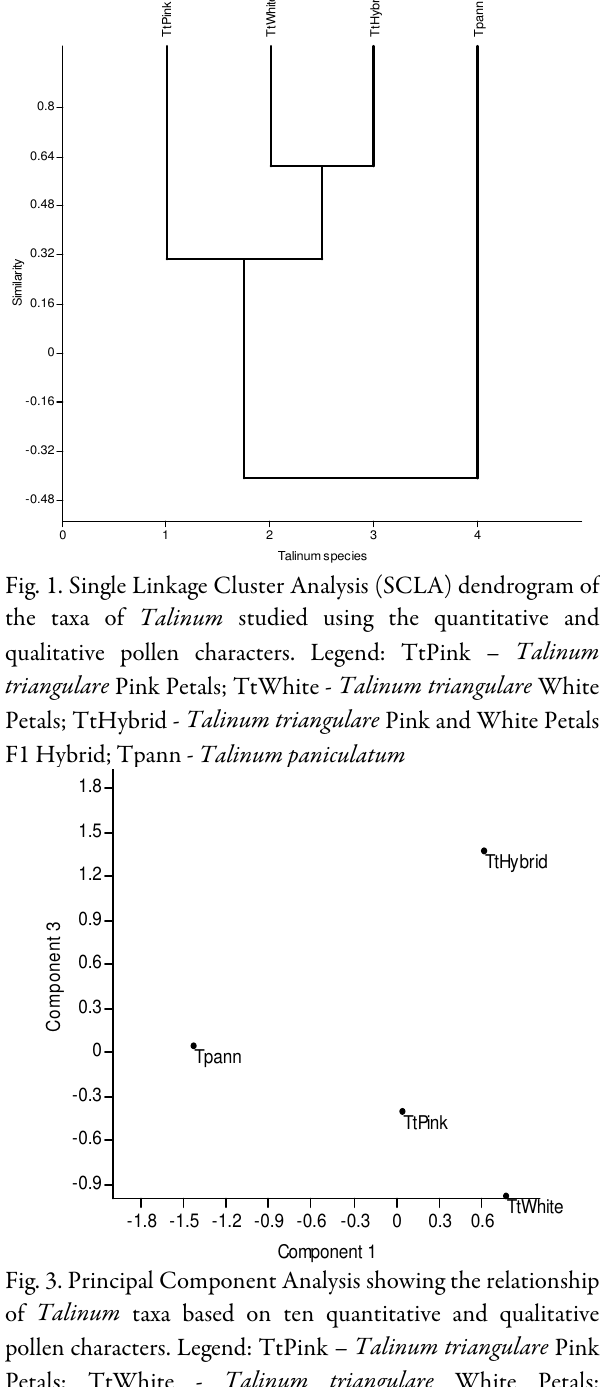
Fig. 3. Principal Component Analysis showing the relationship of Talinum taxa based on ten quantitative and qualitative pollen characters. Legend: TtPink – Talinum triangulare Pink Petals; TtWhite - Talinum triangulare White Petals; TtHybrid - Talinum triangulare Pink and White Petals F1 Hybrid; Tpann - Talinum